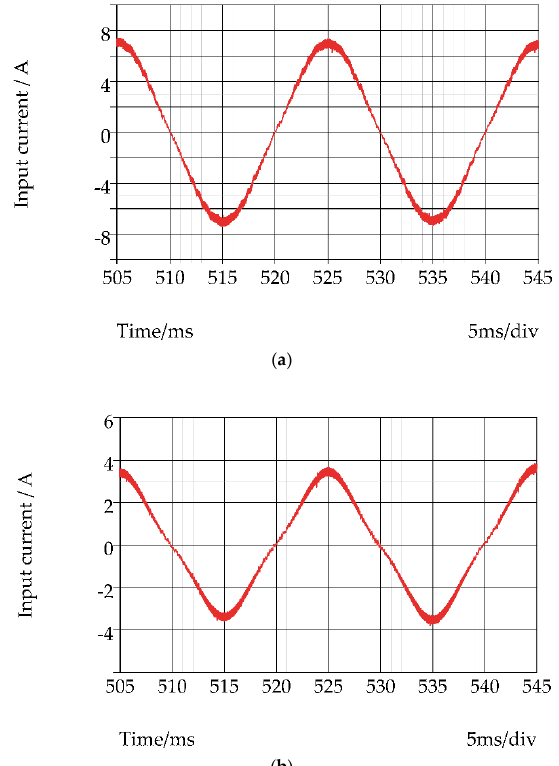
Energies 2018 , 11 , 2640 Figure 9. The input current waveforms after the input LC filter: ( a ) v in = 110 V rms ; ( b ) v in = 220 V rms .